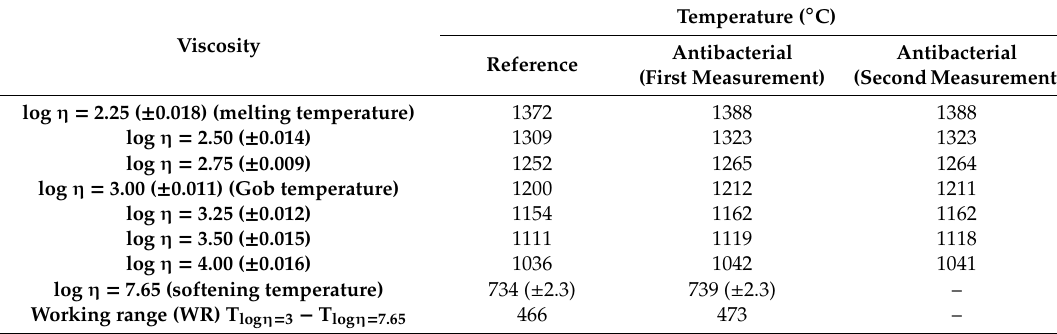
Table 5. Viscosity measurement